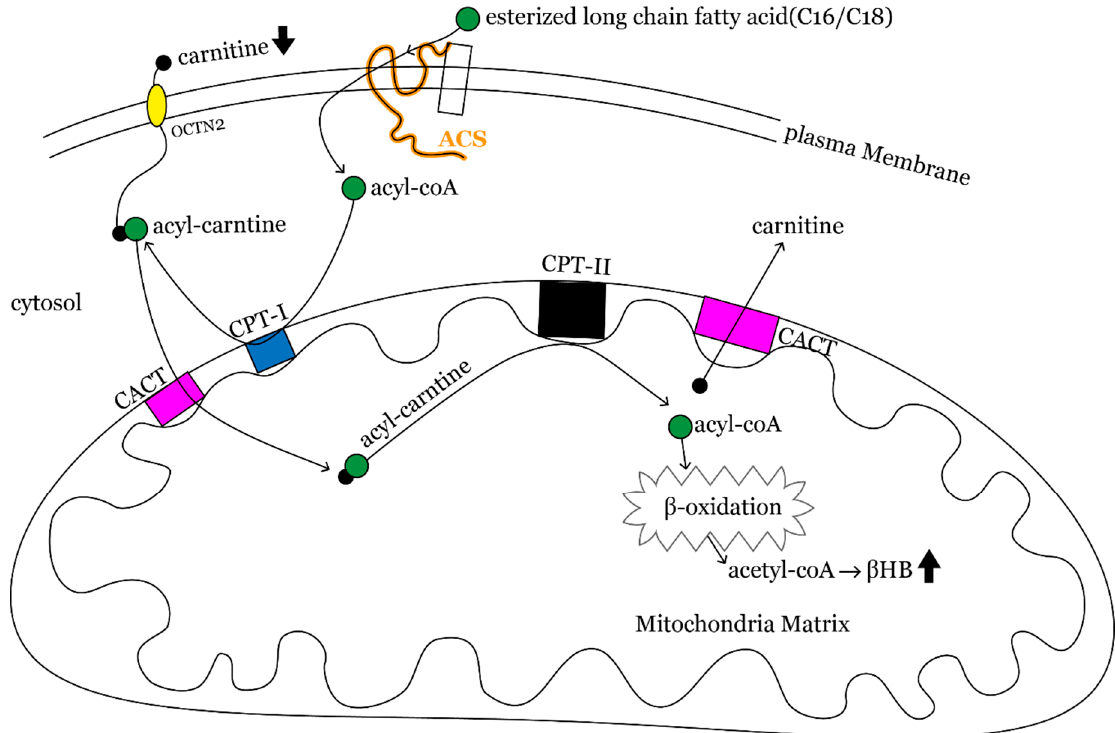
Figure 3. Fatty acid β -oxidation pathway. Fatty acids (especially long-chain fatty acids) undergo acylation, a process catalyzed by acyl-CoA synthases that traps them in the cytoplasm as acyl-CoA thioesters. Acyl-CoA thioesters then conjugate to carnitine with formation of acylcarnitines through the action of carnitine palmitoyl transferase I. Acylcarnitines are translocated across the inner mitochondrial membrane by acylcarnitine translocase. Carnitine can be removed from acylcarnitine by carnitine palmitoyl transferase II inside the mitochondria, and acyl-CoAs are re-generated. Acyl-CoAs can enter β -oxidation in the mitochondrial matrix with final products of acetyl-CoA that produce ketone bodies (mainly β HB) in the liver.